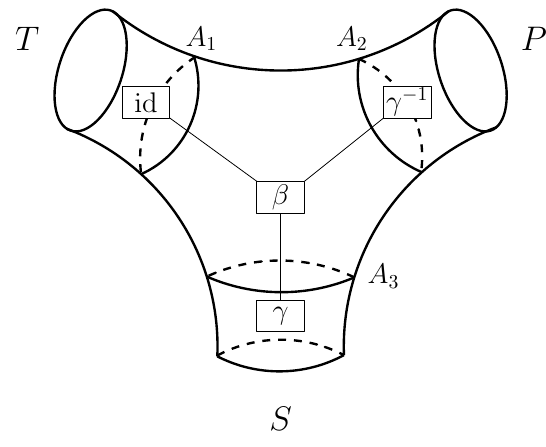
Figure 36 . A three-boundary wormhole